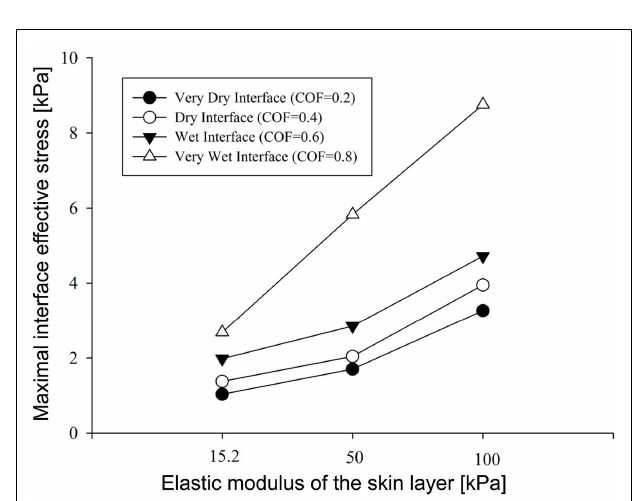
and 1.78–5.41 kPa for skin stiffnesses of 15.2, 50, and 100